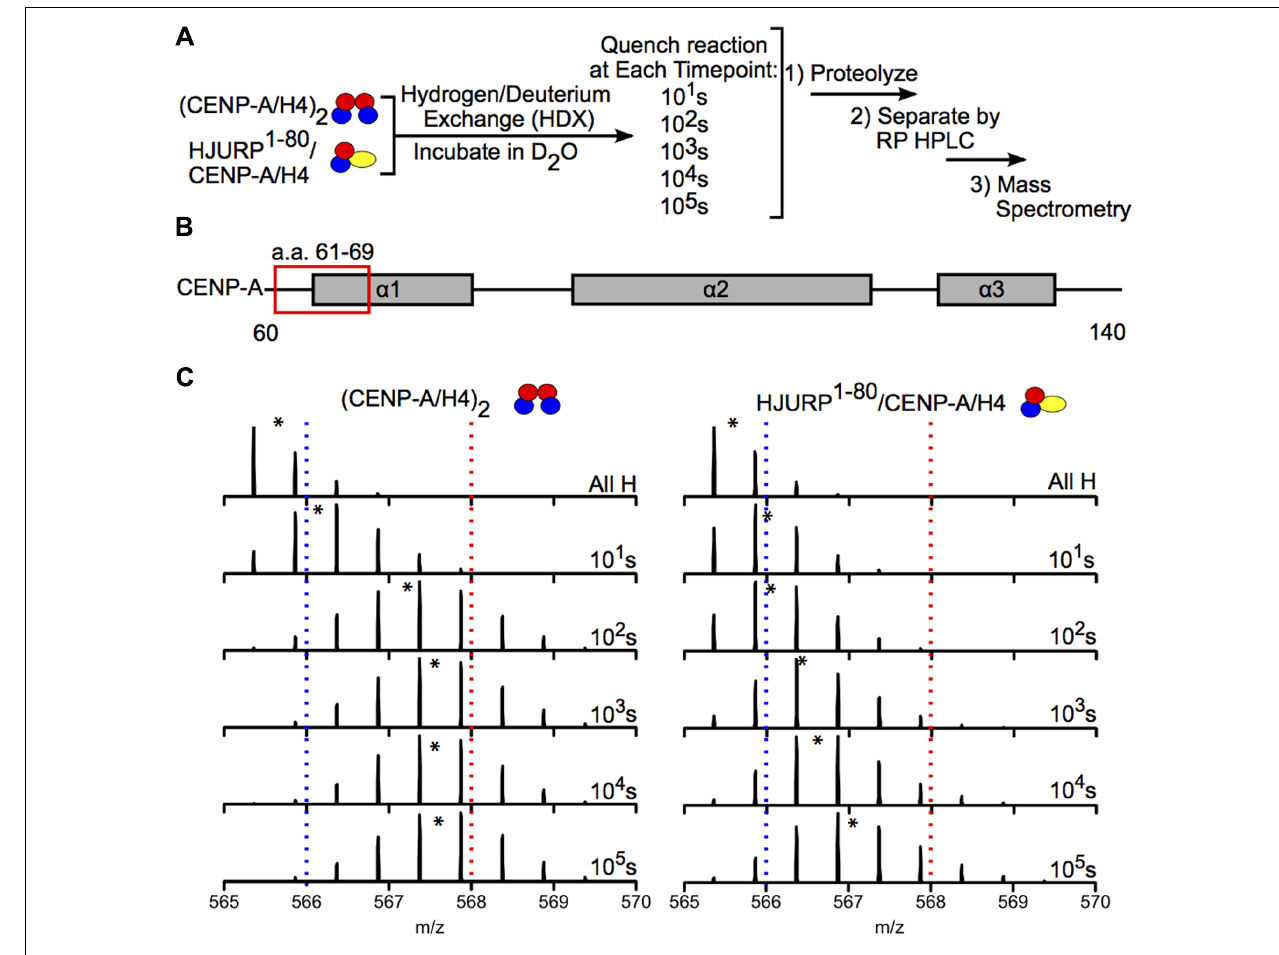
CENP-A peptide 61–69 from (CENP-A/H4) 2 (left) and HJURP 1 − 80 /CENP-A/H4 (right). Black asterisks denote centroid locations, and dotted red and blue lines serve as guideposts to highlight the differences in m / z shifts between the two complexes. Note that the CENP-A peptide is more protected from exchange in the HJURP 1 − 80 /CENP-A/H4 complex compared to the heterotetramer as evidenced by a lower level of deuterium incorporation throughout the time course, where it takes > 100 times as long to achieve the same level of HDX. Data obtained from Bassett etal.